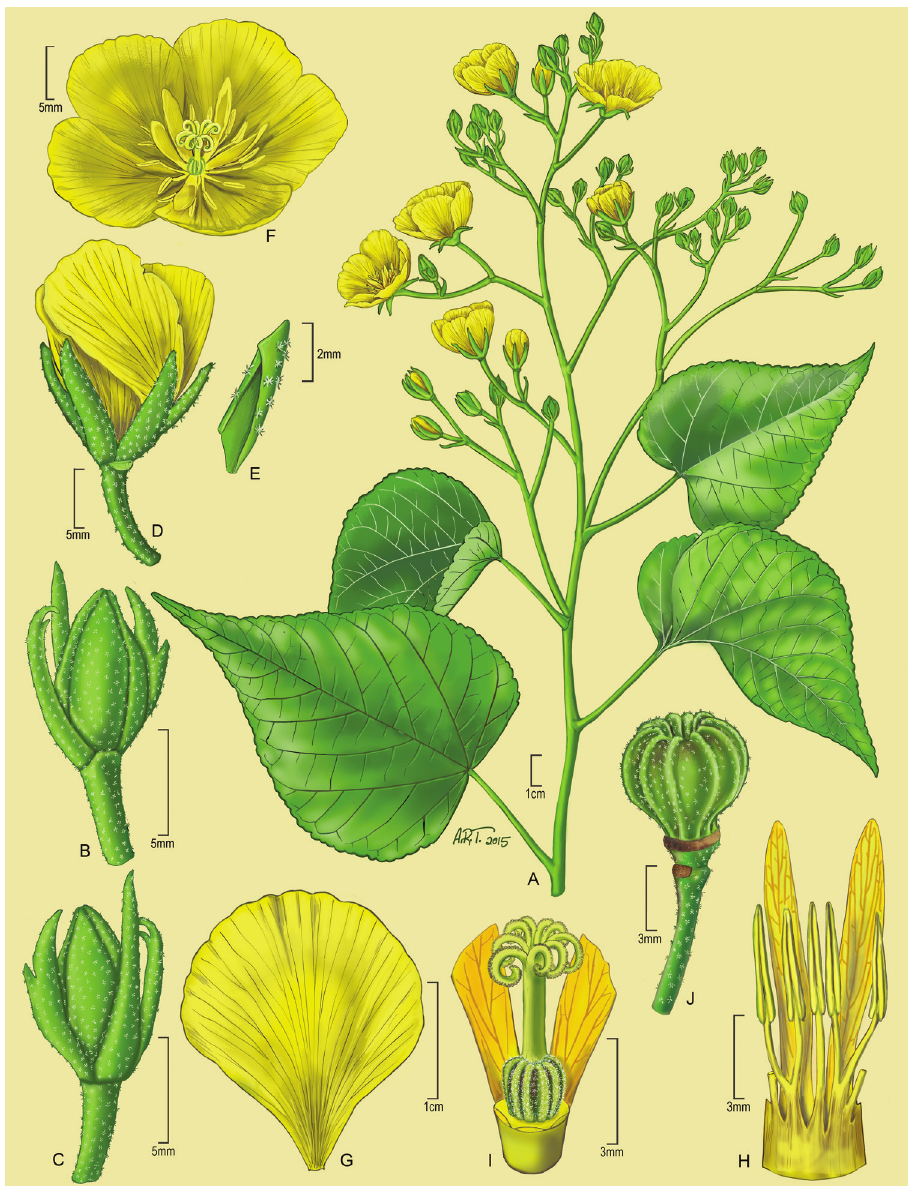
Figure 1. Eriolaena rulkensii . A Habit B, C Flower buds with 3 epicalyx bracts each D Immature flower with petals (yellow), sepals (green) and scar of one dehisced epicalyx bract E Detail of sepal F Flower at anthesis showing petals, anthers, staminodes and gynoecium G Detail of petal H Detail of androecium showing androecial tube, anthers in fascicles and staminodes I Gynoecium and base of two staminodes J Immature capsule showing scars from dehisced calyx lobes and epicalyx bracts. (Source: A.J.H. Rulkens 1 ,